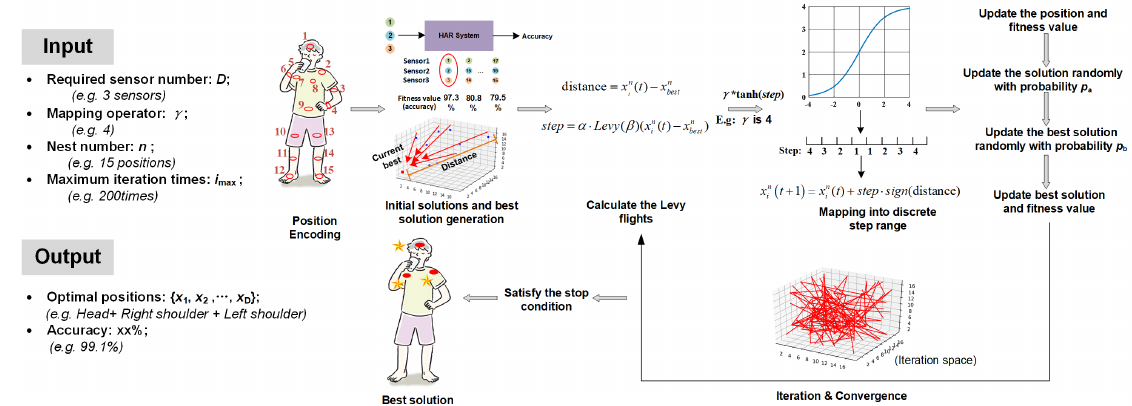
Figure 5. Working process of the proposed ID-CS optimization. After the position space has been defined, the initial solutions and the initial best solution are generated. Then, the iteration starts. The distance between the best solution and the current solution is obtained and multiplied by the mapped Levy length with a step-scaling factor γ to decide the movement of the solution. With probability p a ∈ ( 0,1 ) the current solution will be changed randomly to a new one. Moreover, to help the best solution escape the local optimum trap, the fraction could disturb the position of the existing best solution. Finally, we compared each fitness value to update the best solution until the stop condition is